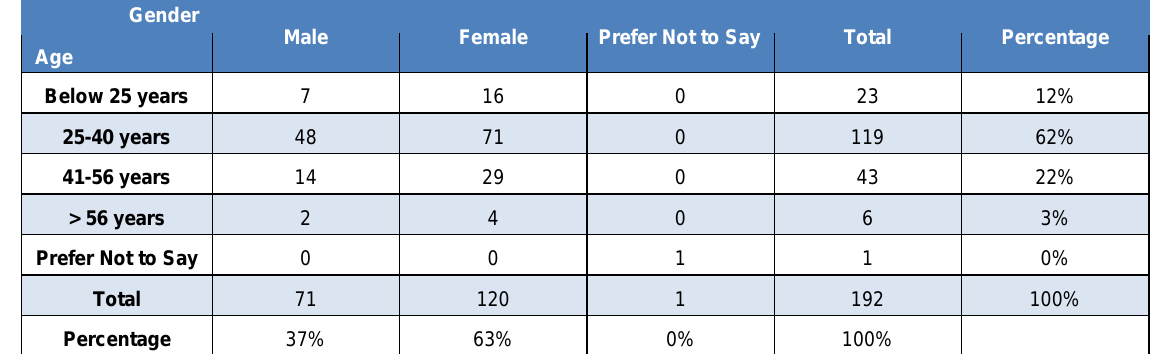
Table 2: Age and gender distribution in sample